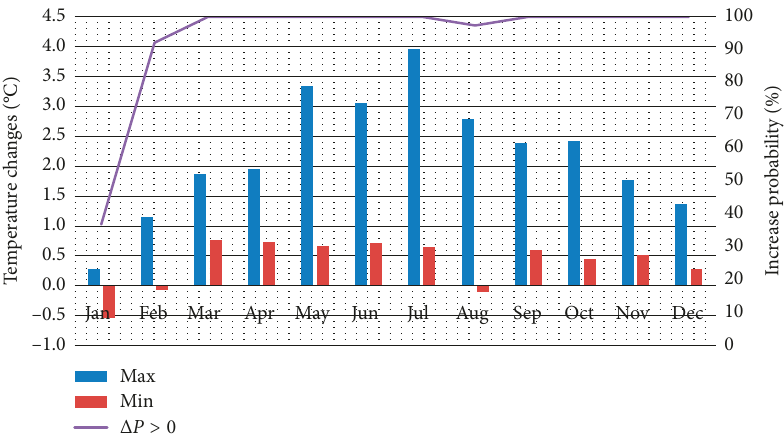
Figure 6: Range of changes in the monthly average of minimum daily temperature in the future near period under all the models and three emission scenarios and their probabilities.